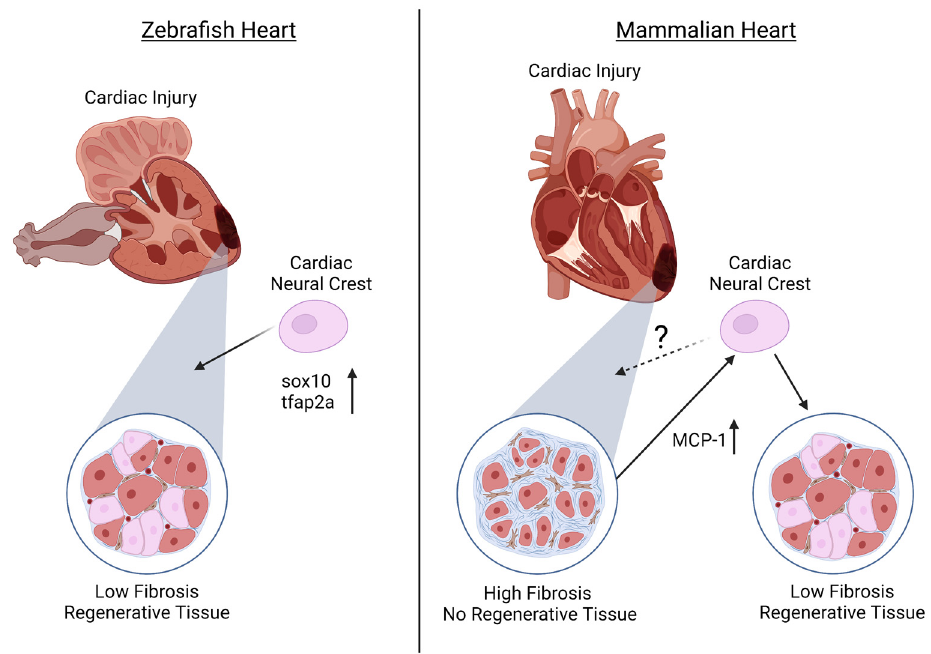
Figure 1. The ability of the cardiac neural crest (NC) to contribute to regeneration after cardiac injury in zebrafish and mammalian hearts. In the zebrafish, injured ventricular tissue has been shown to populate a large number of NC-positive cells that express high levels of sox10 and tfap2a that give rise to cardiomyocytes and myocardium of the regenerated ventricle. In the mammalian heart, the contribution of the NC to the ventricle and their ability to regenerate or maintain a stem cell-like state is still unknown. Although mammalian ventricular cardiac injury results in scarring and fibrosis with little-to-no regenerative ability, there is potential that the injured tissue releases the chemokine MCP-1, signaling to cardiac neural crest cells (NCCs) to migrate to the injury site to assist in tissue regeneration of the ventricle. (Created with Biorender, accessed on 29 November 2022).